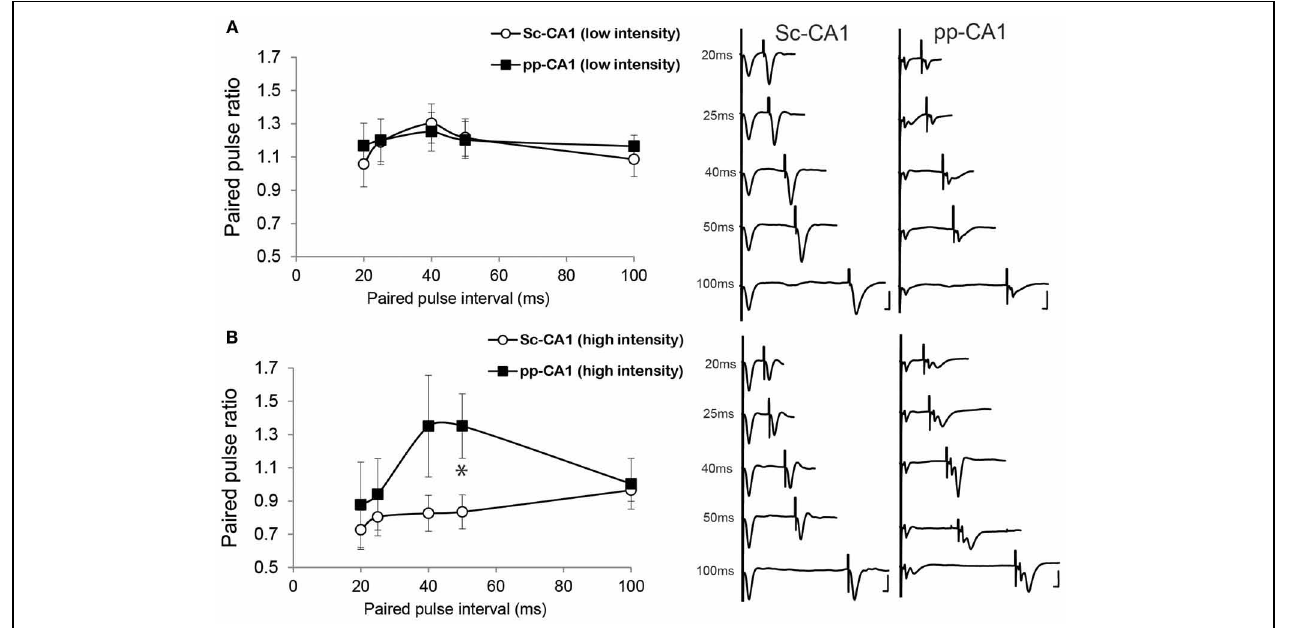
FIGURE 4 | The paired-pulse ratio is different for pp-CA1 and Sc-CA1 synapse depending on stimulus intensity. (A) Left: Paired-pulse ratio profiles for pp-CA1 and Sc-CA1 synapses at low-intensity stimulation (corresponding to the intensity necessary to evoke 40% of the maximum). Right: Example of fEPSPs evoked from corresponding synapse and interstimulus interval (Vertical scale bar: 4mV, horizontal scale bar: 5ms for all) (B) Left: Paired-pulse ratio profiles for pp-CA1 synapses and for the Sc-CA1 synapses at high-intensity levels (double the low-intensity